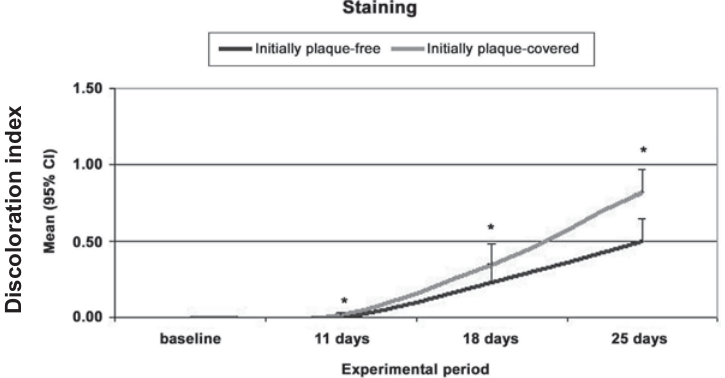
Figure 3- Mean discoloration intensity index in surfaces initially plaque-free or plaque-covered at different experimental periods